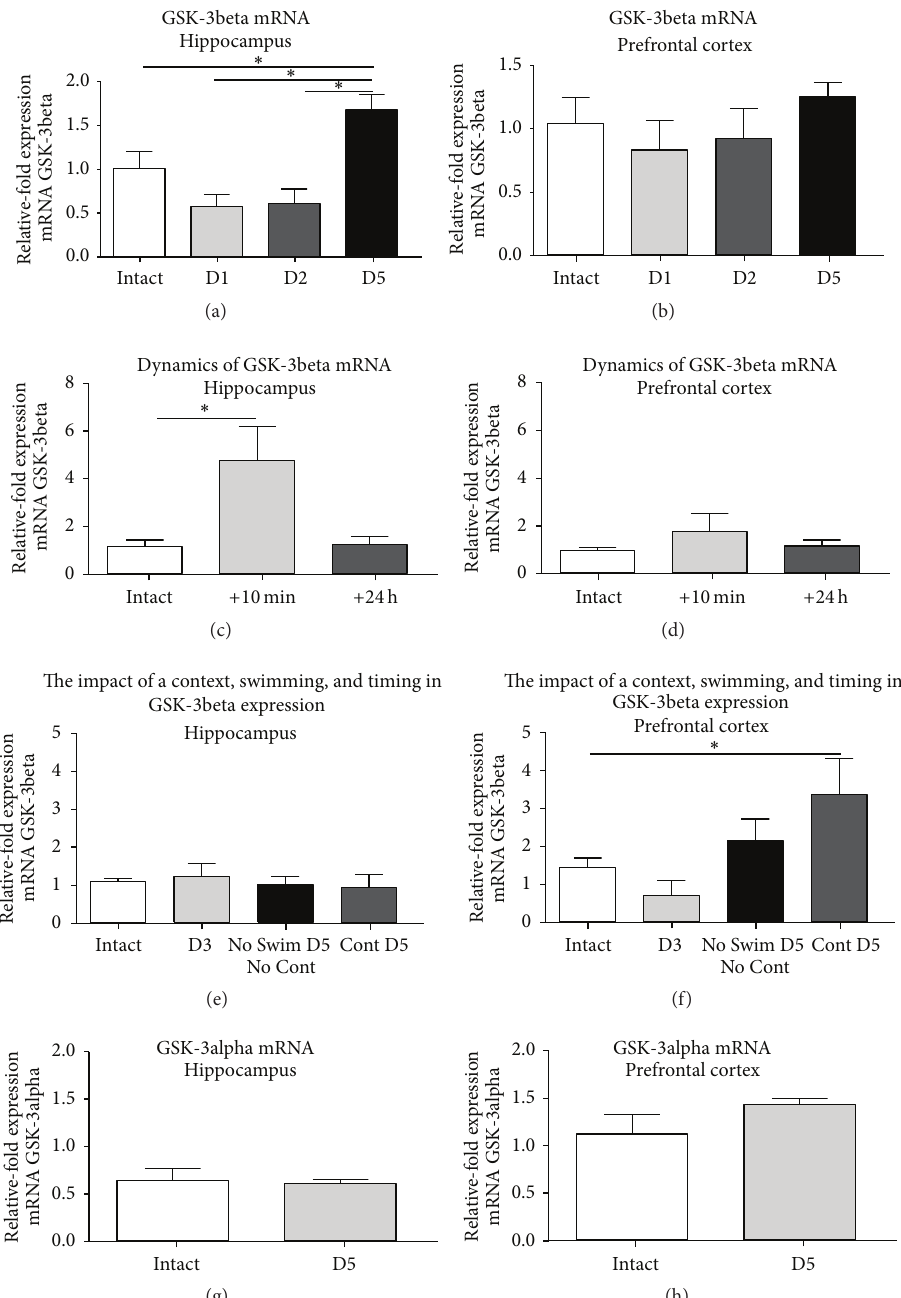
Figure3:BrainexpressionofGSK-3betainthemodifiedswimtestandtheroleofcontext,swimming,andtimingoftesting.(a)Incomparison to intact controls ( 𝑛 = 11 ), hippocampal GSK-3beta mRNA levels were significantly elevated only on Day 5 ( 𝑛 = 14 ), but not on Day 1 ( 𝑛 = 12 ) orDay2( 𝑛 = 11 ).(b)Intheprefrontalcortex,theGSK-3betamRNAlevelswerenotchangedonDay1,Day2,orDay5;groupsizesasindicated above. As compared with intact mice (n = 6 ), there was no change in GSK-3beta mRNA in mice sacrificed 24 h after swim session on Day 5 in the hippocampus (c), nor in the prefrontal cortex (d); 𝑛 = 14 in each experimental group. (e) In comparison to intact controls ( 𝑛 = 10 ), hippocampal GSK-3beta mRNA levels were not significantly altered in mice tested and sacrificed on Day 3 ( 𝑛 = 6 ) nor in mice sacrificed on Day 5 without any behavioural manipulations ( 𝑛 = 6 ) or exposed to a context at testing on Day 5 ( 𝑛 = 6 ). (f) In comparison to intact controls, GSK-3beta mRNA levels were not changed in the prefrontal cortex of mice exposed to testing on Day 3, nor in mice sacrificed on Day 5 without any behavioural manipulations, and significantly elevated in animals exposed to a context of testing on Day 5; group sizes as indicated above. As compared with intact mice ( 𝑛 = 9 ), in mice exposed to the modified swim test ( 𝑛 = 13 ), there was no change in GSK- see the text; +10min: mice sacrificed 10min after swim session; +24 h: mice sacrificed 24 h after swim session; D3: mice exposed to the swim session on Day 3 instead of a swim on Day 5; Cont D5: mice exposed to a context of testing instead of a swim session on Day 5; no swim D5: mice were not exposed to a swim nor a context of swimming test prior a sacrifice. D1: Day 1; D2: Day 2; D5: Day 5. Data are mean ±